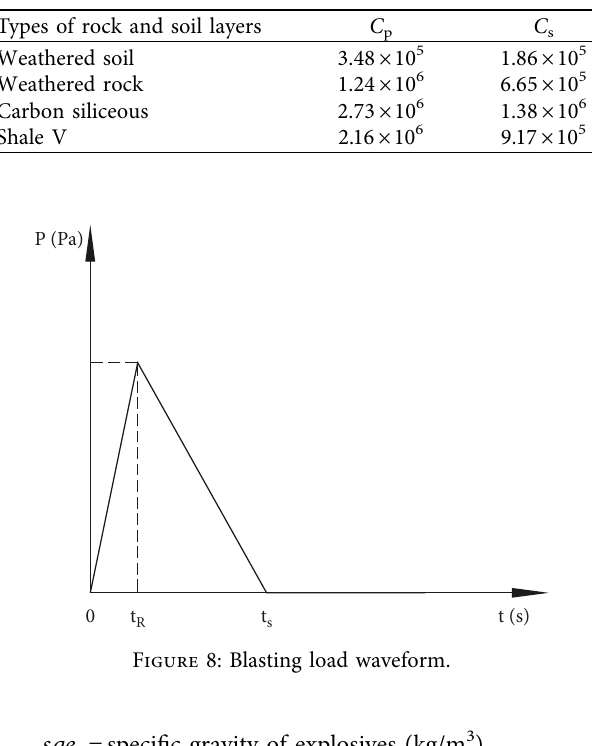
Table 4: Damping coefficient of model foundation (N · Sec/m).